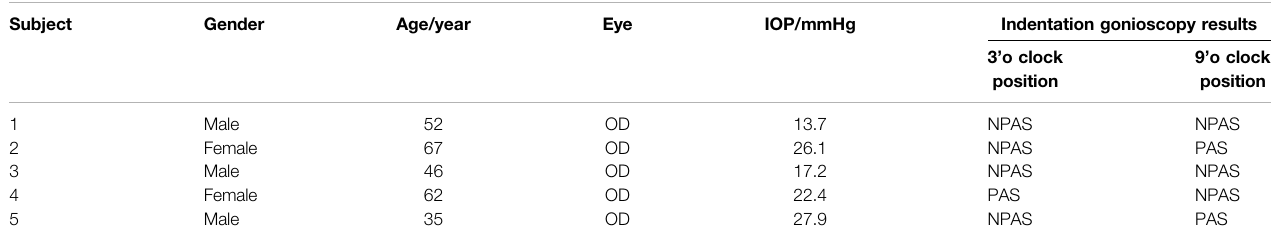
TABLE 2 | Clinical characteristics of patients with angle closure glaucoma.